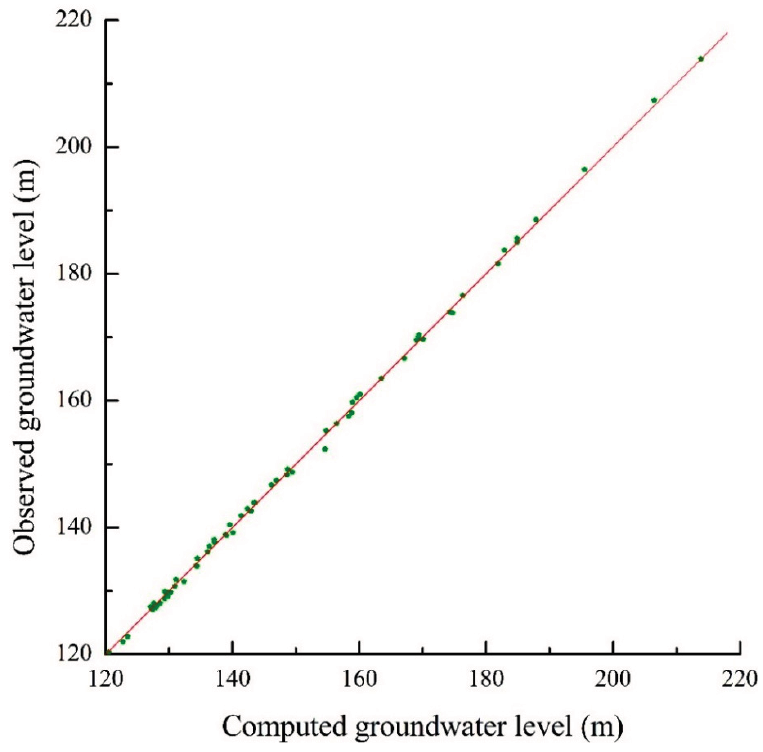
Figure 5. The fitting chart of the groundwater table between measured and computed of each observation well at the end of the model verification stage.